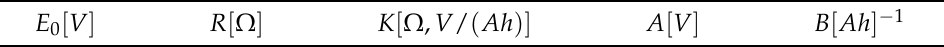
Table 1. Parameters Tremblay’s